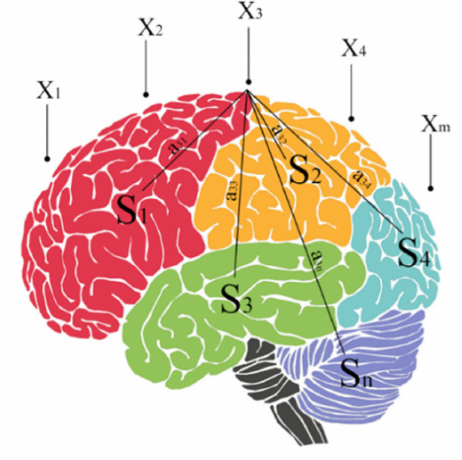
Figure 1. Signal mixing process of the electroencephalogram